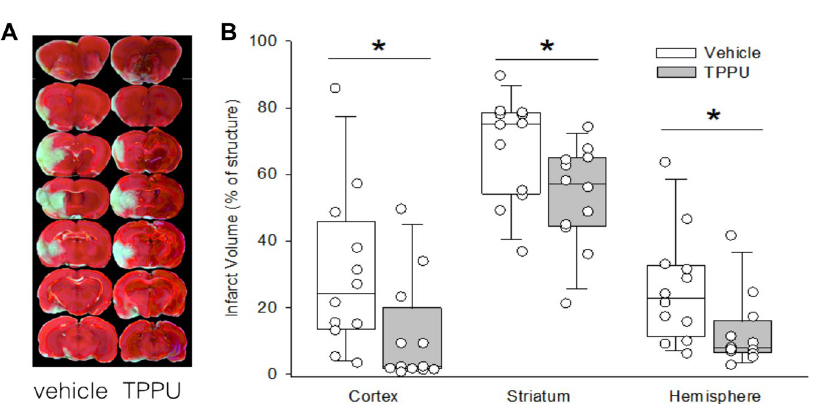
Figure 3. TPPU decreases infarct volume. Representative images of TTC-stained brain sections show that infarct volume was smaller in rats administered TPPU at reperfusion than in those administered vehicle. Individual values of infarct size percentage in cortex, striatum, and hemisphere obtained at 2 d are shown along with box-whisker plots of the median and the 5, 25, 75, and 95% ranges. Comparisons between the vehicle and TPPU groups were made with the Mann-Whitney test ( n = 12 rats per group; * p < 0.05 vs. vehicle